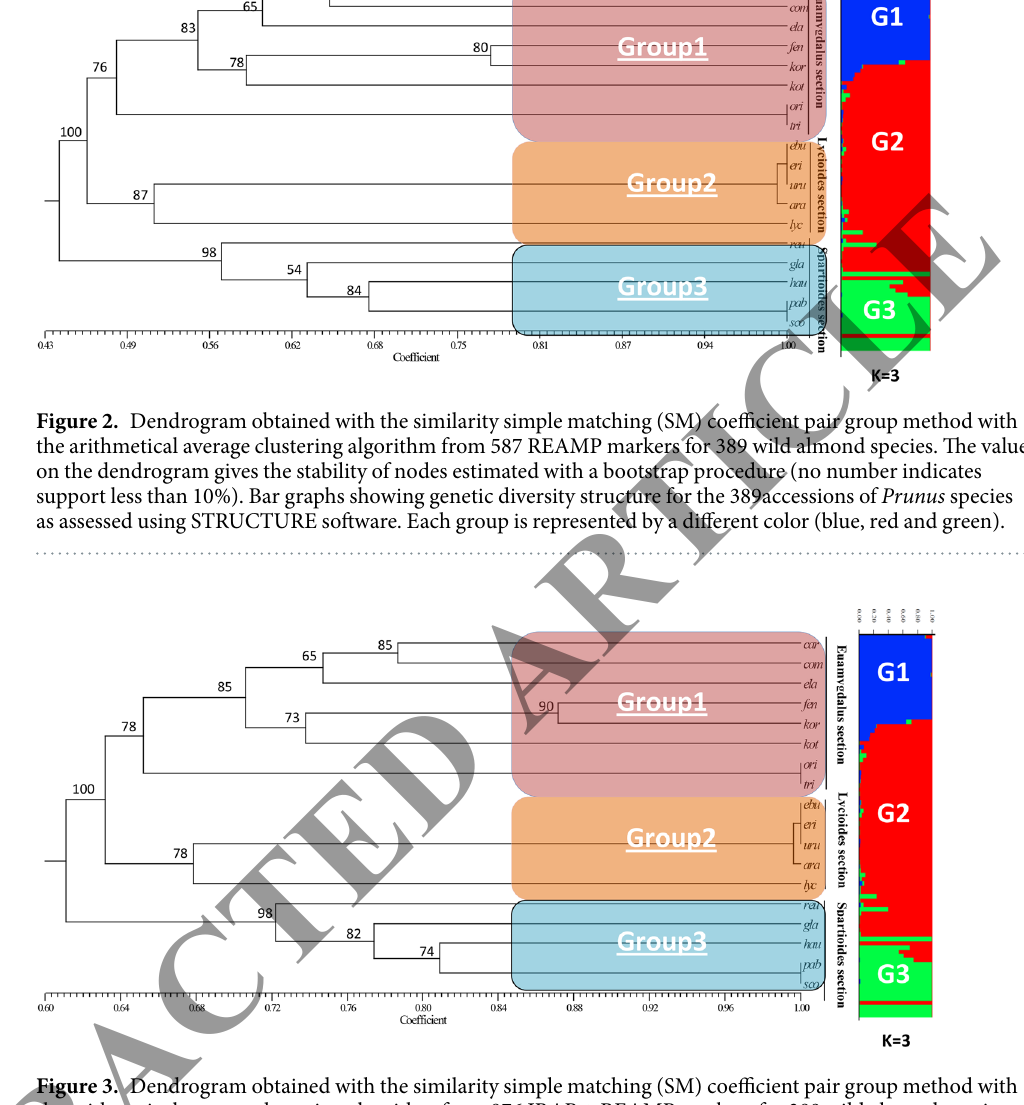
Figure 3. Dendrogram obtained with the similarity simple matching (SM) coefficient pair group method with the arithmetical average clustering algorithm from 876 IRAP + REAMP markers for 389 wild almond species. The value on the dendrogram gives the stability of nodes estimated with a bootstrap procedure (no number indicates support less than 10%). Bar graphs showing genetic diversity structure for the 389accessions of Prunus species as assessed using STRUCTURE software. Each group is represented by a different color (blue, red and